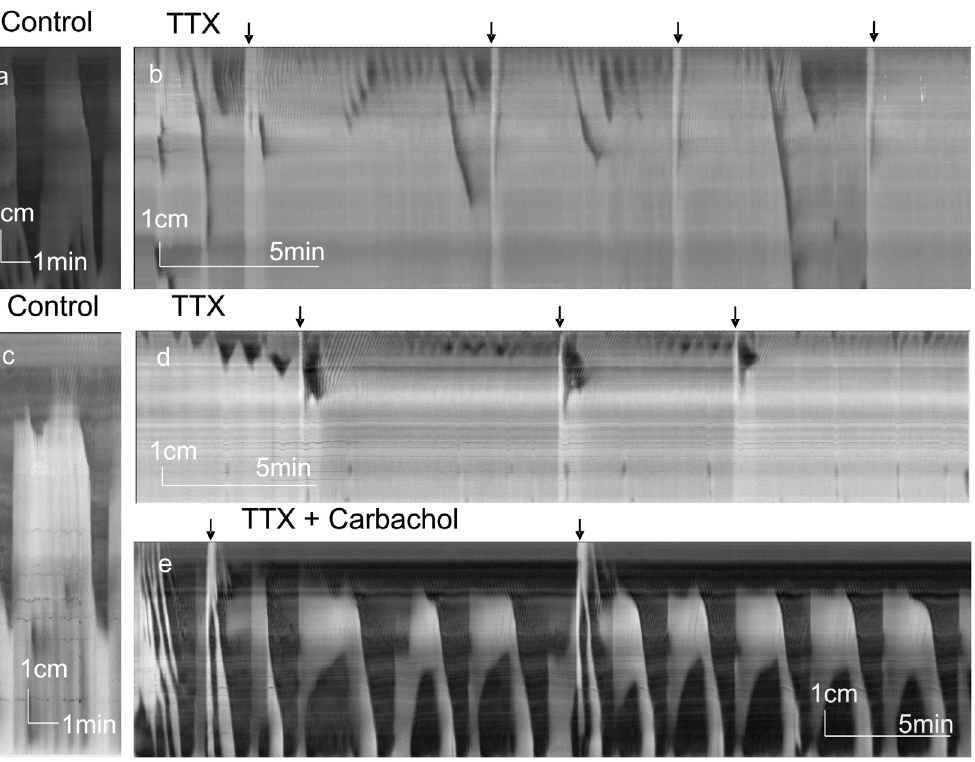
Figure 3. Effect of TTX on LDCs. Spatiotemporal maps created from video recordings of motor patterns of the whole rat colon. All arrows indicate infusion of PBS into proximal colon. a. Control LDCs followed by addition of TTX, added 1 min before the start of panel b. b. TTX abolished induced and rhythmic LDCs. Fluid infusion occurred at arrows. Rhythmic contractions remained in the proximal colon and a few propagated into the mid colon. c. Control LDCs (different animal). d. TTX was added 7 min before the start of panel d. TTX abolished induced and rhythmic LDCs. Rhythmic motor activity remained in the proximal colon. e. Carbachol, 2 6 10 2 6 M, was added 10 min before start of panel e. Carbachol, in the presence of TTX induced rhythmic LDC-like activity as well as retrograde contractions in the distal colon.